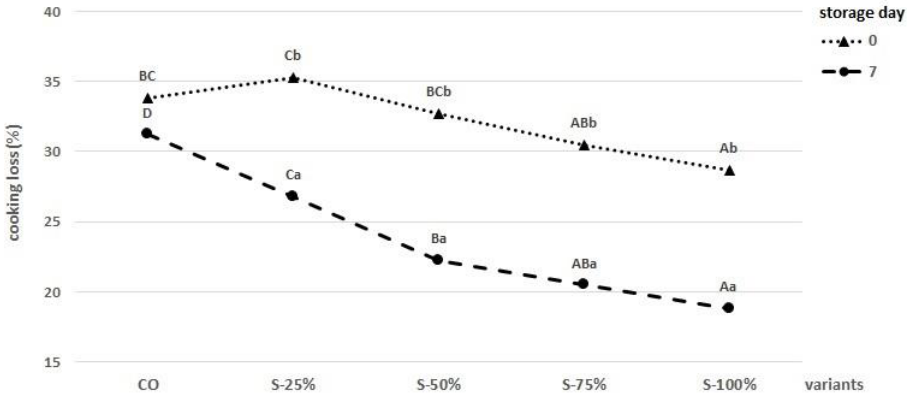
Figure 2. Analysis of cooking losses in grilled burgers with fat replacement after 0 and 7 days of storage. A–D —means with different letters showing a significant effect of the treatment group in the same day of storage, p < 0.05. a,b —means with different letters showing a significant effect of storage time in each treatment group, p > 0.05.